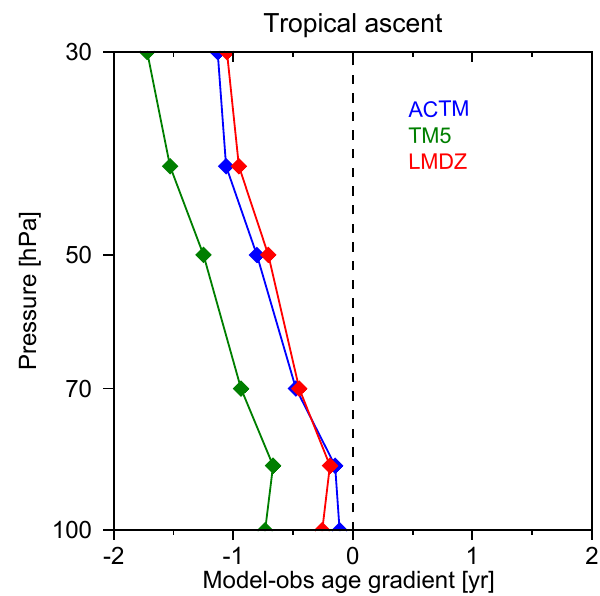
Figure 8. Model–MIPAS differences of the mean age gradient as a transport diagnostics for tropical ascent. The mean age gradient was calculated as the difference between the lower stratospheric mean ages averaged over 35–50 ◦ N and 10 ◦ S–10 ◦ N. Mean age data in years (yr) are calculated as annual means on the MIPAS pressure– latitude